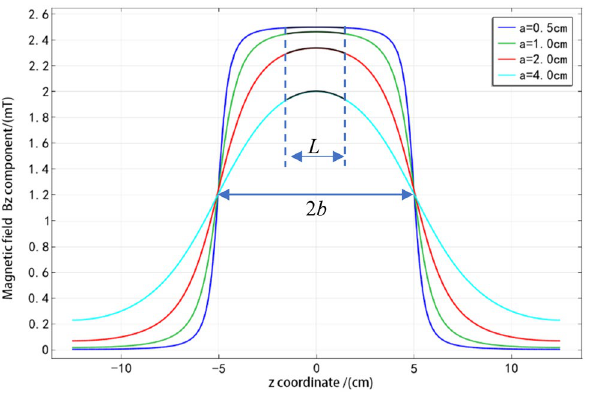
Figure 3. Distribution of B z component on the axis when b is constant and a is